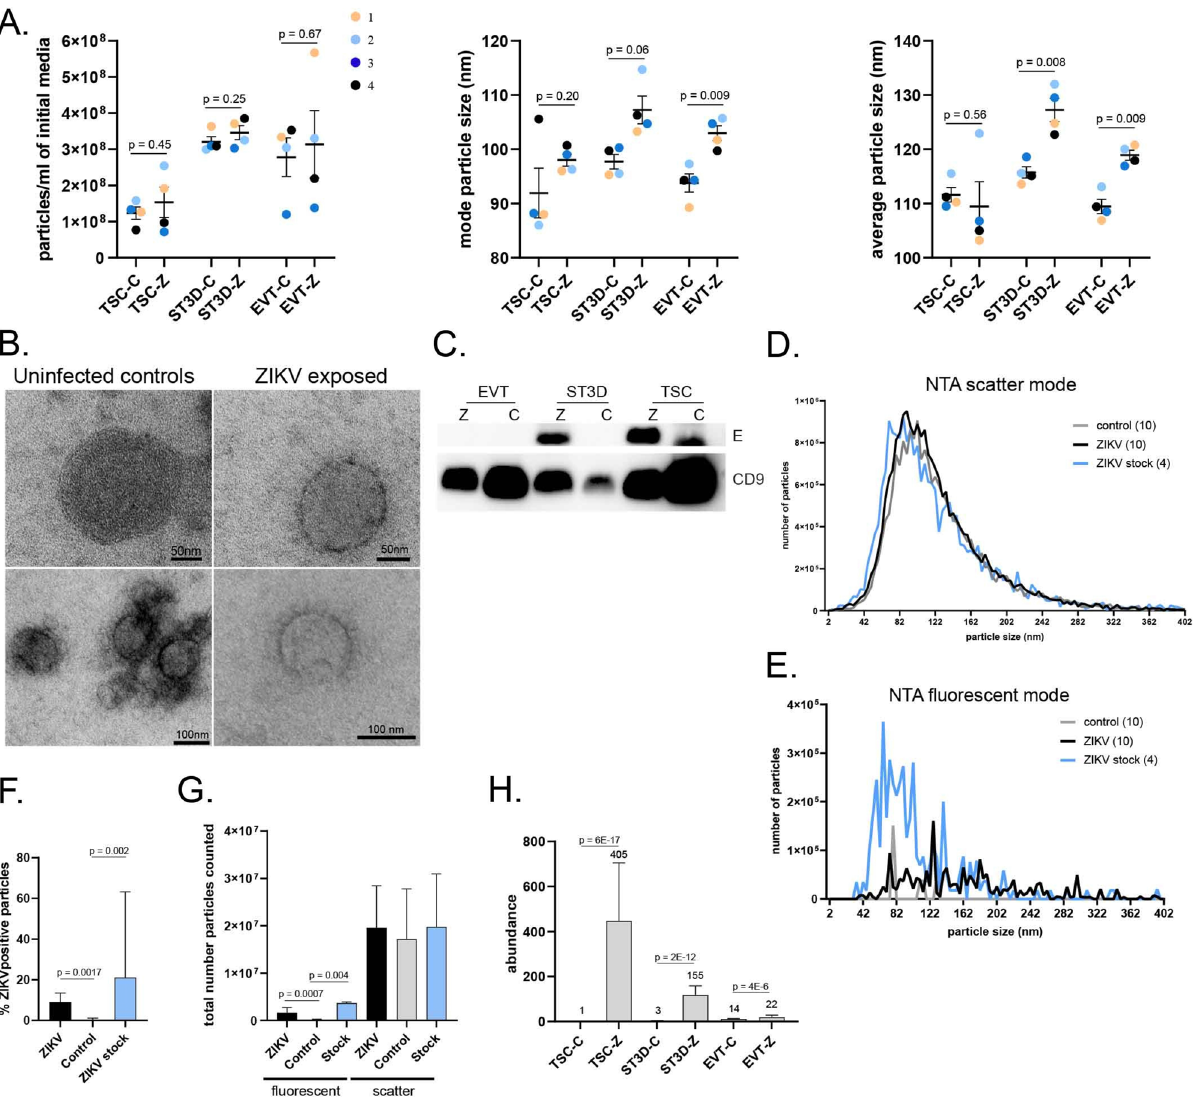
Figure 4. EV characterization from trophoblast-conditioned media. ( A ) NTA analysis of the particles presented as the particles/ml, the mode, and average particle size in nm for all 24 EV samples. Paired t-tests with Bonferroni correction were done to check significance. ( B ) Representative TEM images of four EV samples (two control and two ZIKV) with scale bars included. ( C ) Western blots of EV samples for ZIKV E and CD9. ( D , E ) EV samples were characterized with NTA scatter and fluorescent mode. The average number of particles detected across the control samples, ZIKV samples, and ZIKV stock were plotted against particle size. The number of samples is indicated in the parentheses. Bar graphs of the ( F ) percentage (%) of ZIKV positive particles and ( G ) the total number of particles counted. Graphs show the median and interquartile range. Statistical analysis was done with unpaired Mann–Whitney tests. ( H ) The average ZIKV protein abundance (numbers on the graphs) by group as determined by mass spectroscopy. Significance was determined with a t test (background based) and Benjamini–Hochberg correction (FDR). Significance is indicated on the graph where